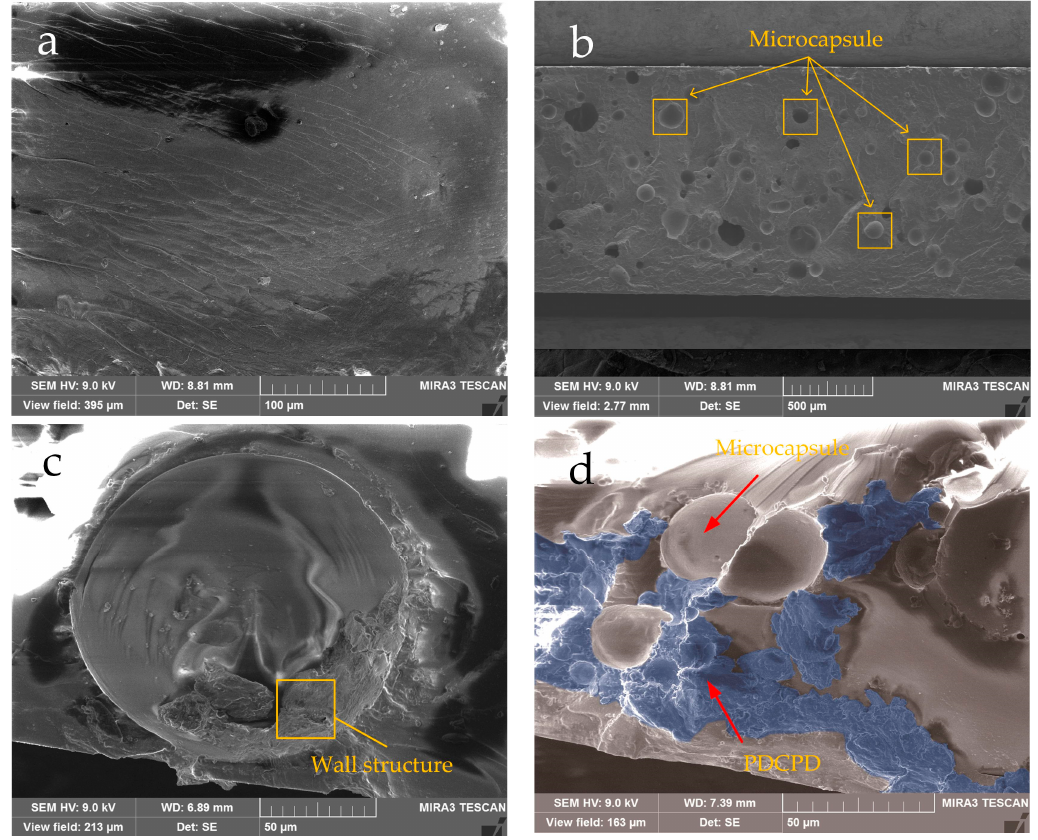
Figure 5. Cross-section characteristics of epoxy resin. ( a ) Pure epoxy resin; ( b ) and ( c ) Composites before reaction; and ( d ) Repair effect.